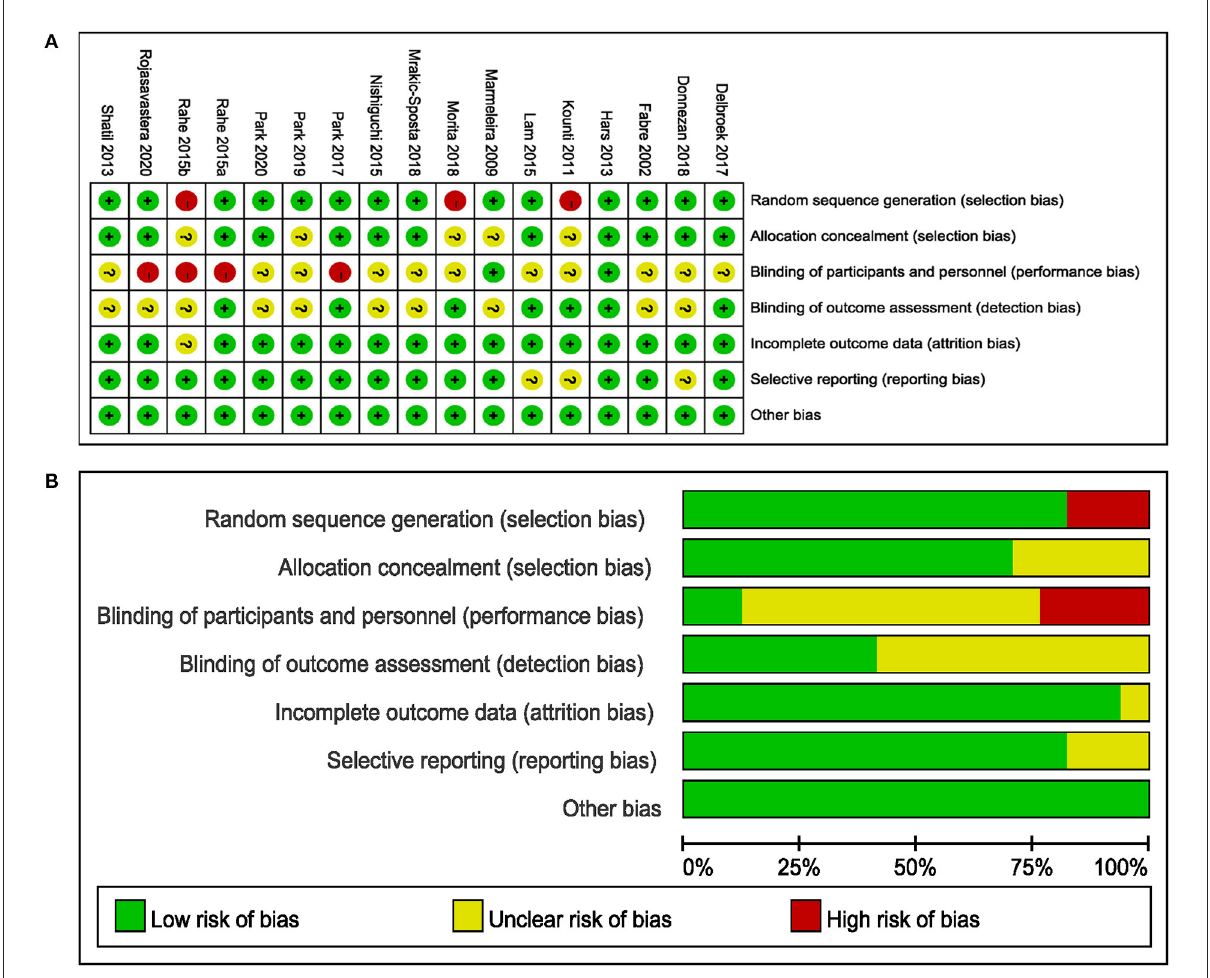
FIGURE2 Results from the Cochrane risk of bias (ROB) tool. (A) ROB graph and (B) ROB